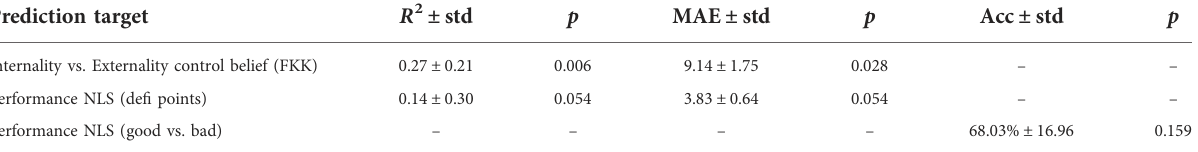
TABLE 3 Summary of the regression and classi fi cation results.